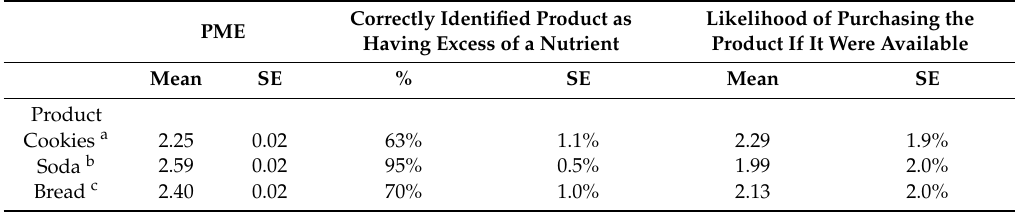
Table A4. Predicted means and percentages by product type, for perceived message e ff ectiveness of the label and assessment of a single product high in sugar, saturated fat, or sodium. Correctly Identified Product as PME Having Excess of a